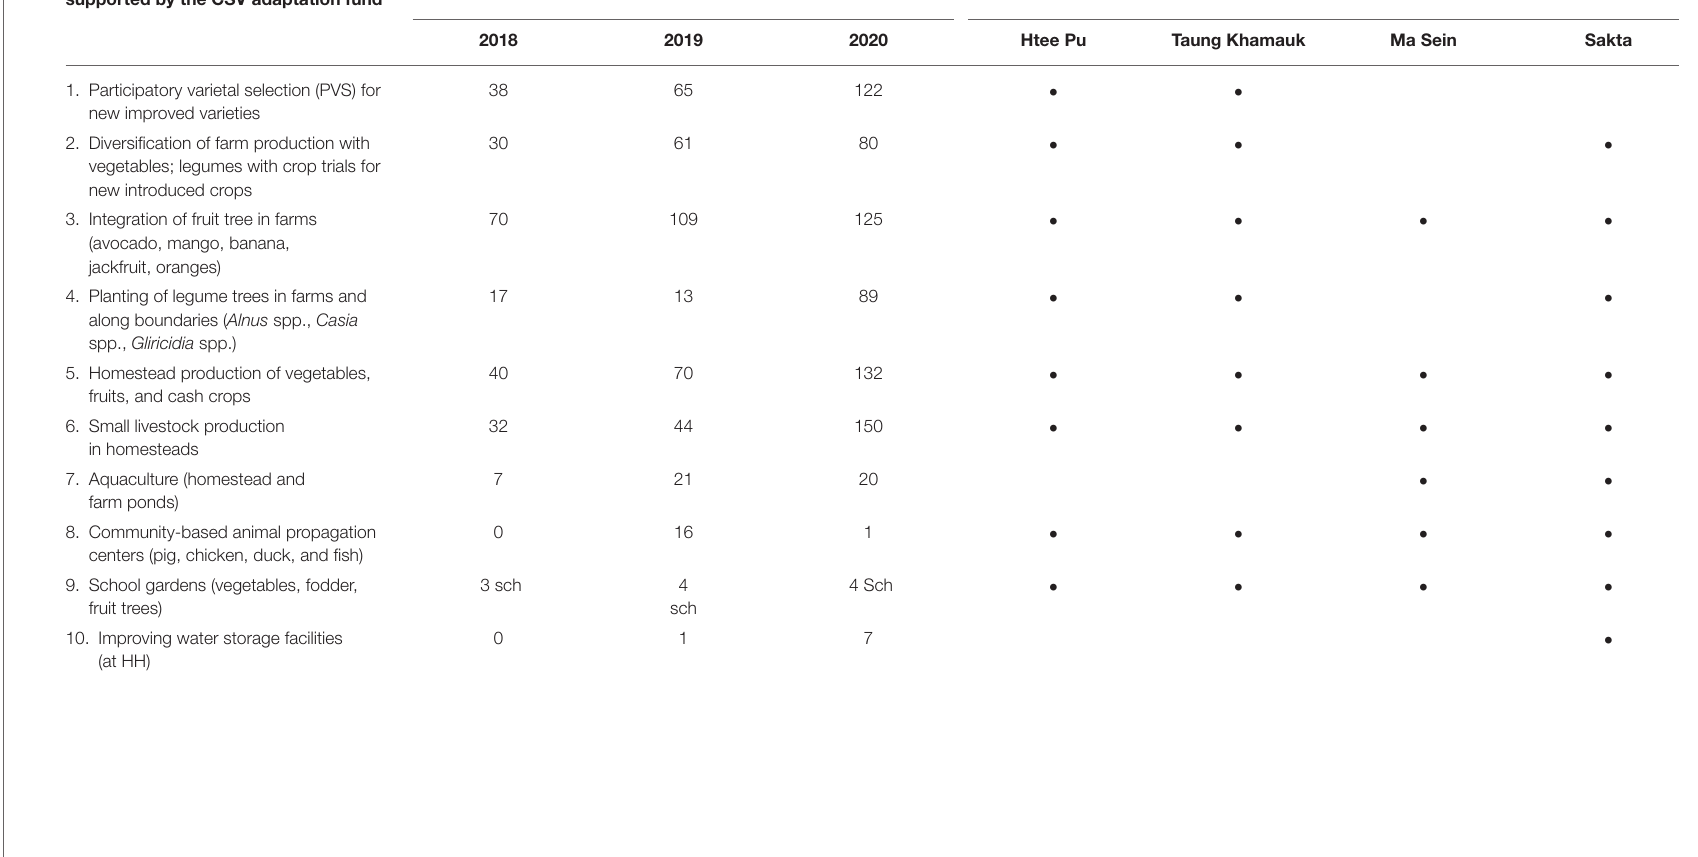
TABLE 6 | Numbers and location of adopters of identified adaptation options, Myanmar, 2020. Climate change adaptation options No. of individual adopters (unless otherwise supported by the CSV adaptation fund